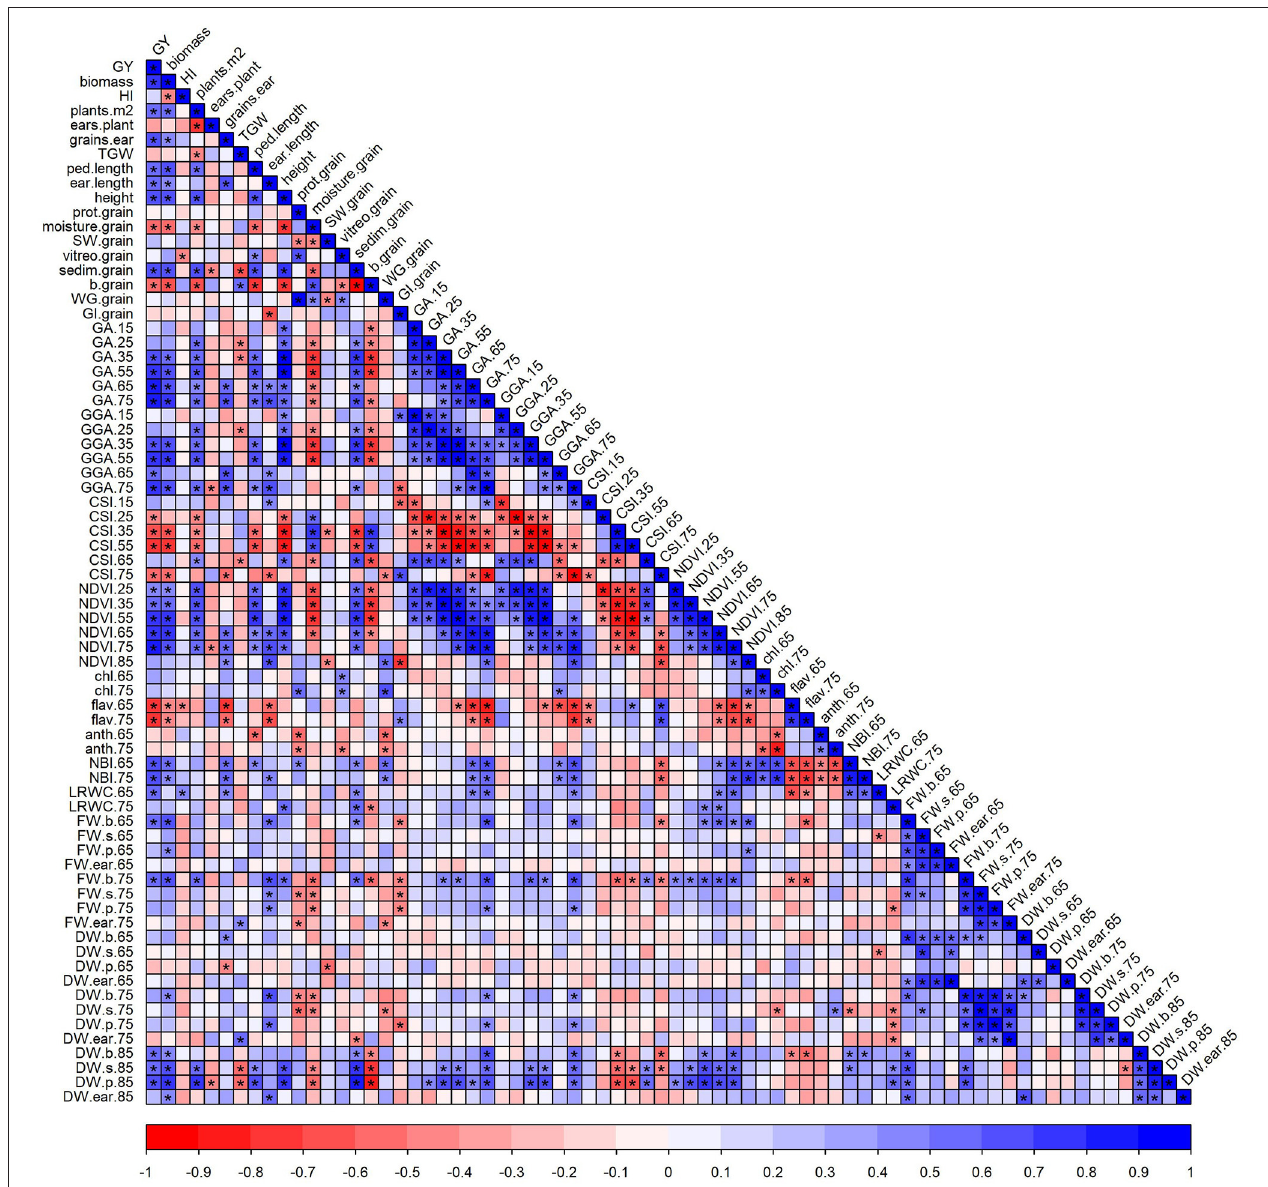
FIGURE 4 | The correlation matrix of agronomic components and grain quality and physiological traits. Each point of the matrix is a Pearson correlation coefficient between two traits (blue, positive correlation; red, negative correlation). Asterisks indicate a significant correlation ( p < 0.05). The abbreviations are described in Supplementary Table 1